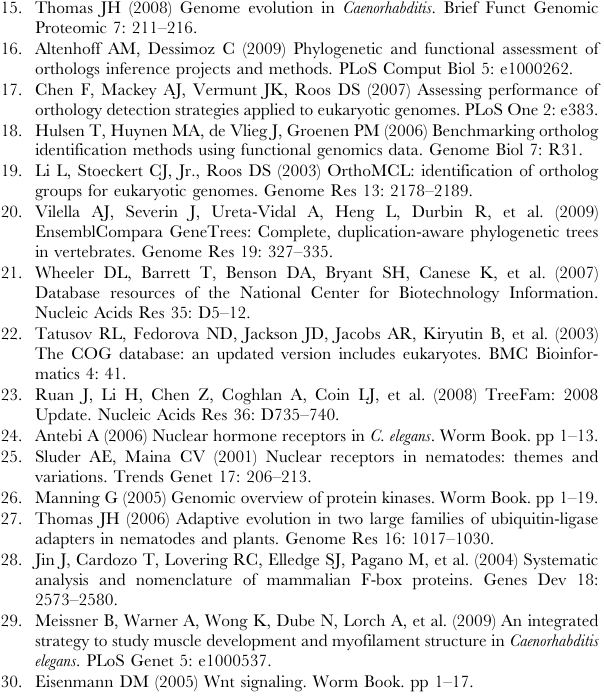
Table S5 Analysis conserved signal transduction pathways. A) Table S6 Analysis of So¨nnichsen et al cell division RNAi screen. A) Screen hits updated to Wormbase WS210. B) Hits in OrthoList. C) Hits not in OrthoList. D) Assessment of orthology, based on RBH/TreeFam, for hits not in OrthoList. E) Assessment of orthology based on RBH/TreeFam, for hits in OrthoList not reported by So¨nnichsen, et al, as having human homologs. Table S7 OrthoList genes with clones in Kamath, et al RNAi feeding library. Table S8 Analysis of Balklava et al trafficking RNA screen. A) Screen hits updated to Wormbase WS210. B) Hits in OrthoList. C) Hits not in OrthoList. D) Assessment of orthology, based on RBH/TreeFam, for hits not in OrthoList. E) Assessment of orthology based on RBH/TreeFam, for hits in OrthoList not reported by Balklava et al as having human homologs. Table S9 Analysis of the worm transcription factor compendi- um, wTF2.0. A) wTF2.0 transcription factors found in OrthoList. B) wTF2.0 transcriptions factors not found in OrthoList. C) Distribution (by program) of TFs found in OrthoList, not scored as having human orthologs in wTF2.0. D) TFs found by all four programs used to compile OrthoList methods, but not scored as having human orthologs in wTF2.0. E) TFs found by single OrthoList programs, not scored as having human orthologs by wTF2.0. Table S10 InterPro annotation of OrthoList. A) Gene-focused pivot report. B) InterPro domain-focused pivot report. C) All OrthoList genes with InterPro domains (6,951/7,633, or , 91%),